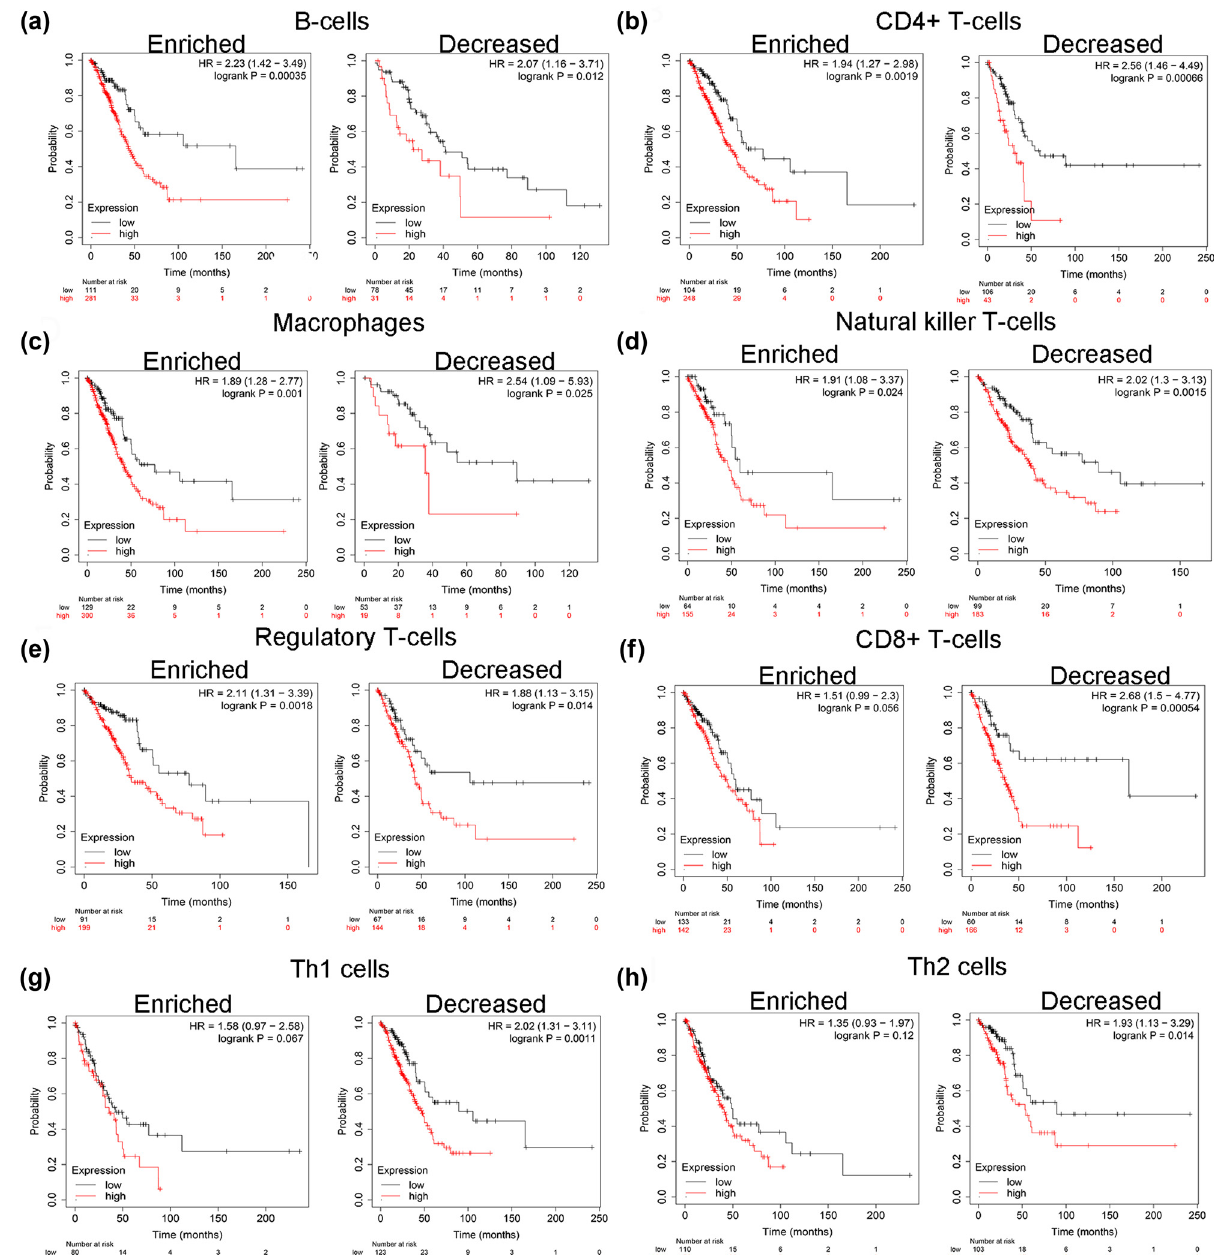
Figure 6: Prognostic signi fi cance of COL11A1 expression based on immune cell enrichment in LUAD patients. The association between COL11A1 and OS was analyzed in enriched and decreased immune cell subgroups of B cells ( a ) , CD4 + T cells ( b ) , CD8 + T cells ( c ) , macrophages ( d ) , NK T - cells ( e ) , Treg cells ( f ) , Th1 cells ( g ) and Th2 cells ( h )